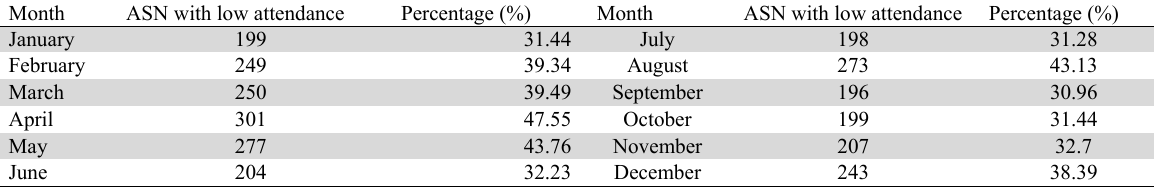
The Data of Morning and Afternoon Attendance of ASN in the Regional Secretariat of Southeast Sulawesi from January